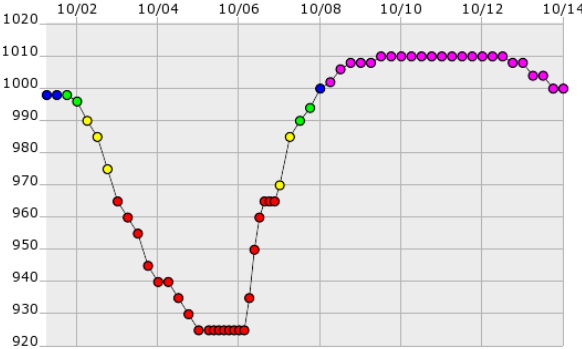
Figure 3. Representing central pressure, in hPa, of the track shown in Figure 2 as plotted with Fig. 3. Representing central pressure, in hPa, of the track shown in respect of corresponding date/time with the same color code. Fig. 2 as plotted with respect of corresponding date/time with the same color code.